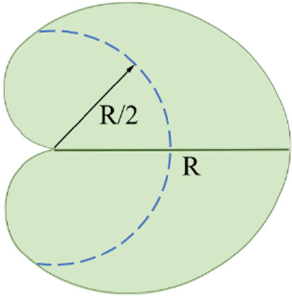
Figure 6. Detail of a sector of the “shamrock” shaped coverage area.